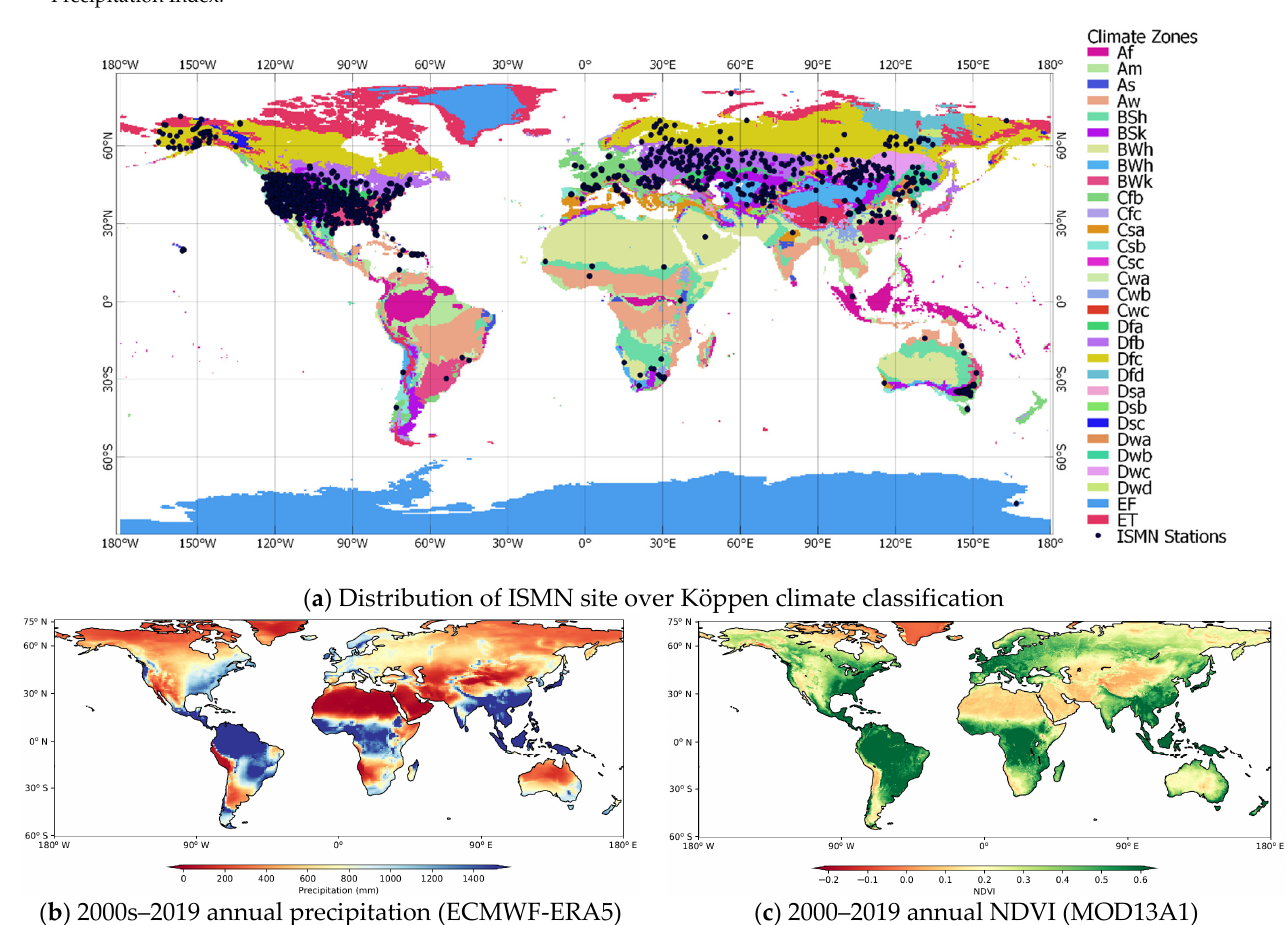
Figure 1. Distribution of the ISMN in situ over Köppen climate classification, annual Precipitation, and NDVI.